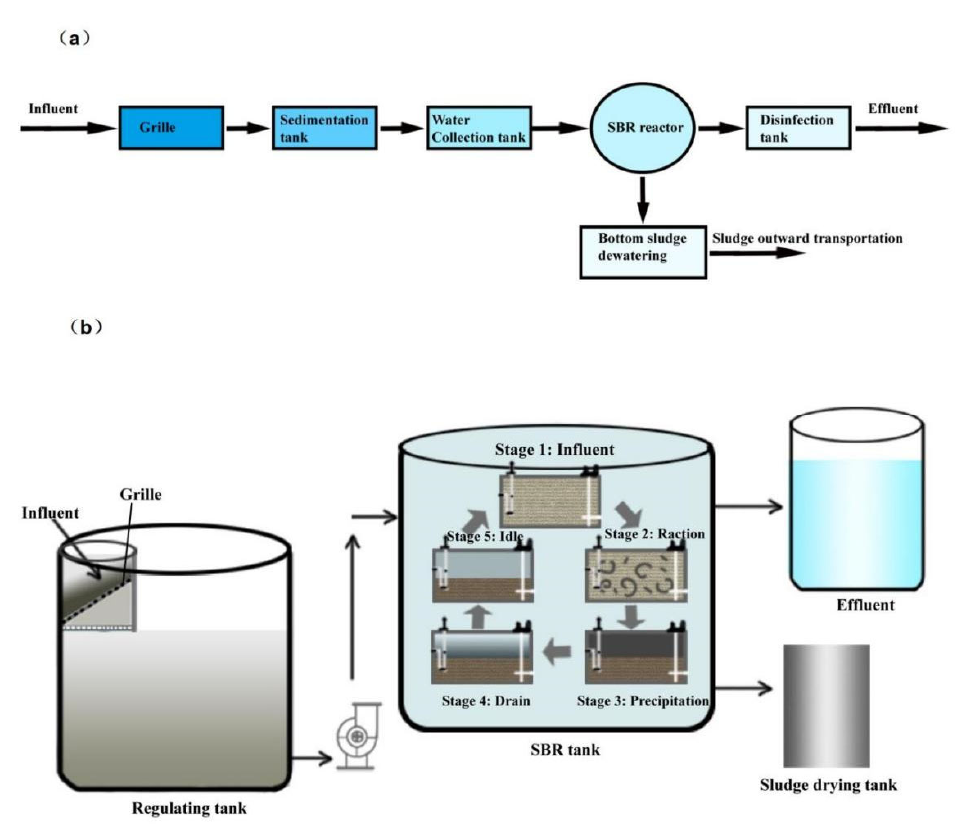
Figure 4. SBR process flow ( a ) and schematic diagram ( b ).